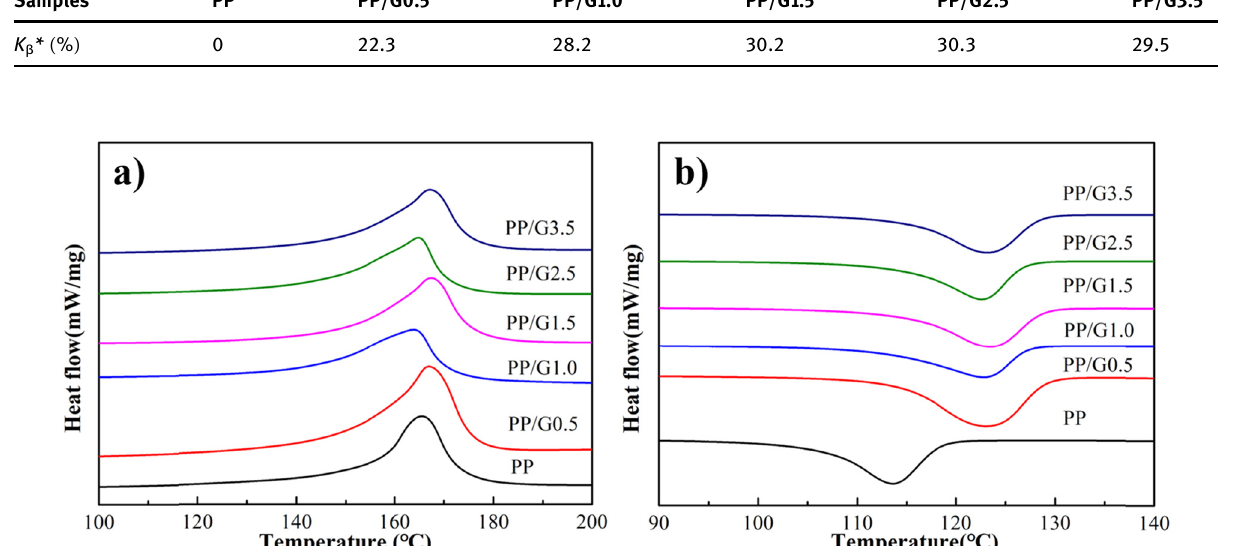
Figure 3: Melting ( a ) and crystallization ( b ) thermograms of neat PP and PP/GNP